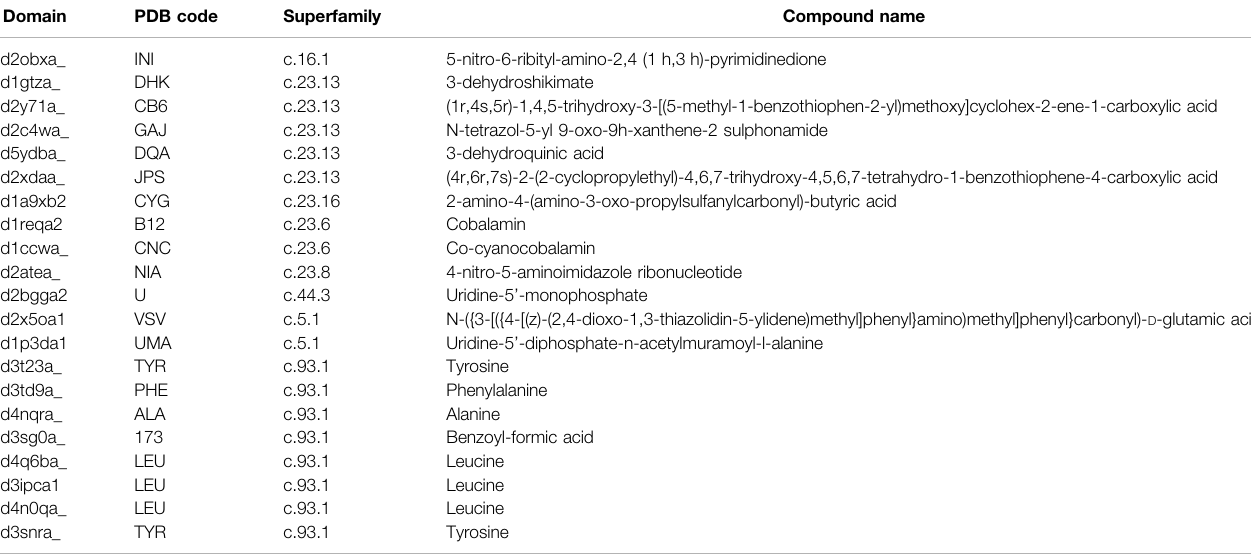
TABLE 1 | List of domains containing cluster 13 with bound